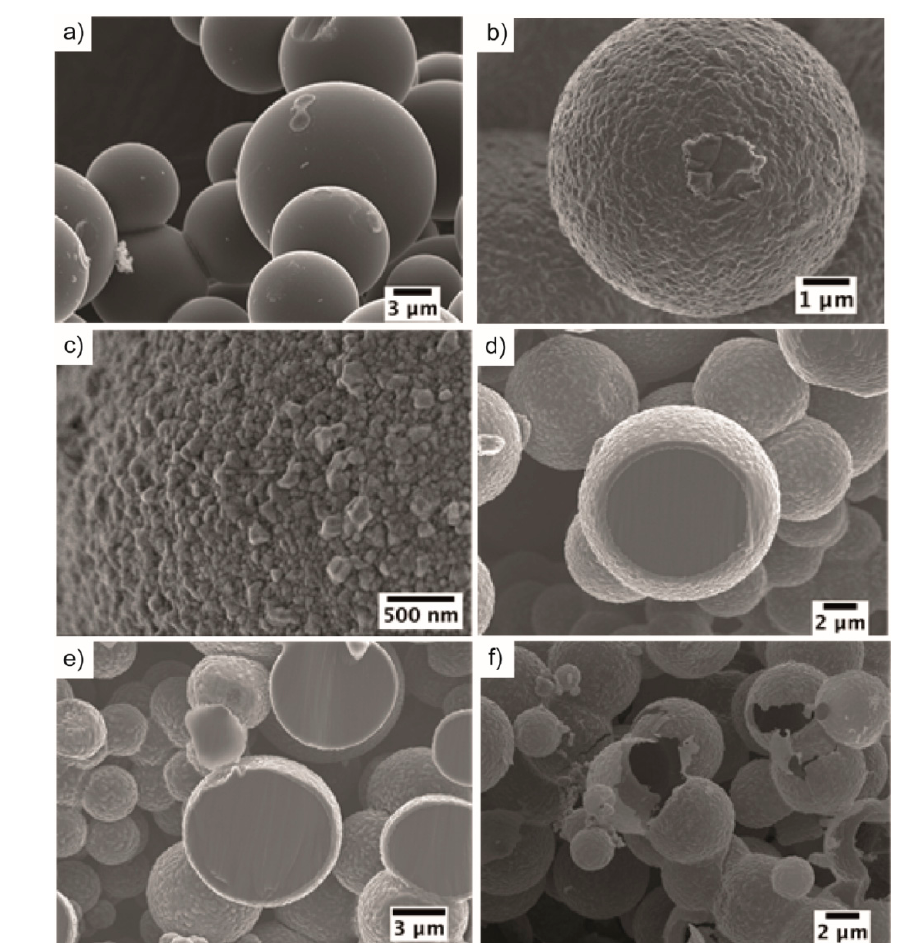
Figure 1. SEM images of ( a ) hydrochar of glucose, ( b ) core-shell C-SiC particles, ( c ) the surface of a core-shell particle, ( d , e ) cross-sections of core-shell particles, ( f ) hollow particles of SiC.